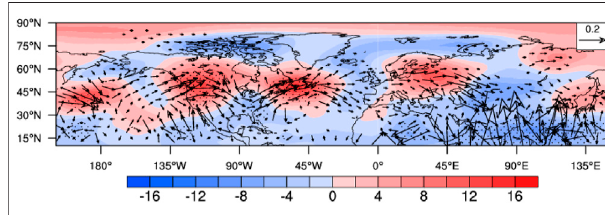
FIGURE 12 | Regression coef fi cients of West Wind Drift index in May – Julywith500 hPageopotentialheightanomaly(shading,gpm)andwave activity fl ux from July to September (vector, m 2 /s 2 ). The dotted areas indicate the coef fi cients that are signi fi cant at the 90% con fi dence level. Only the